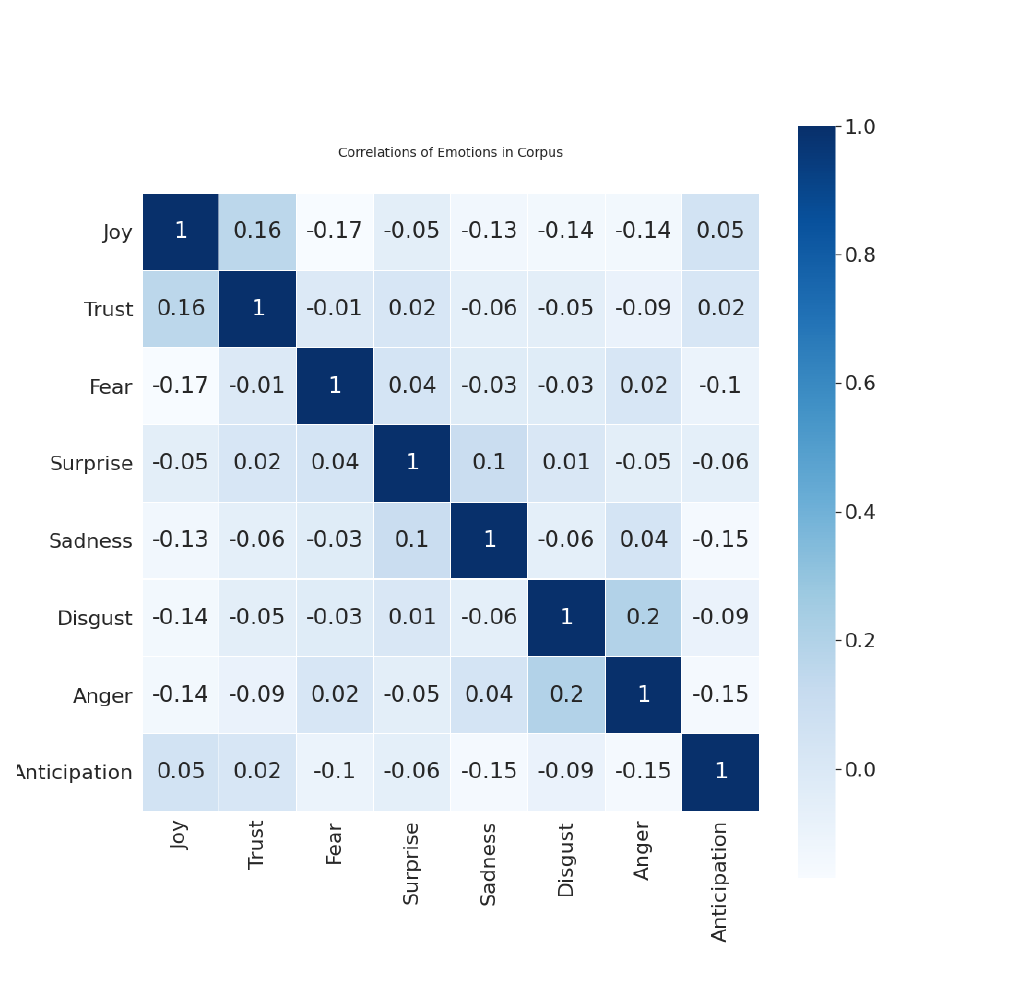
Figure 7. Correlation of emotion’s classes in the